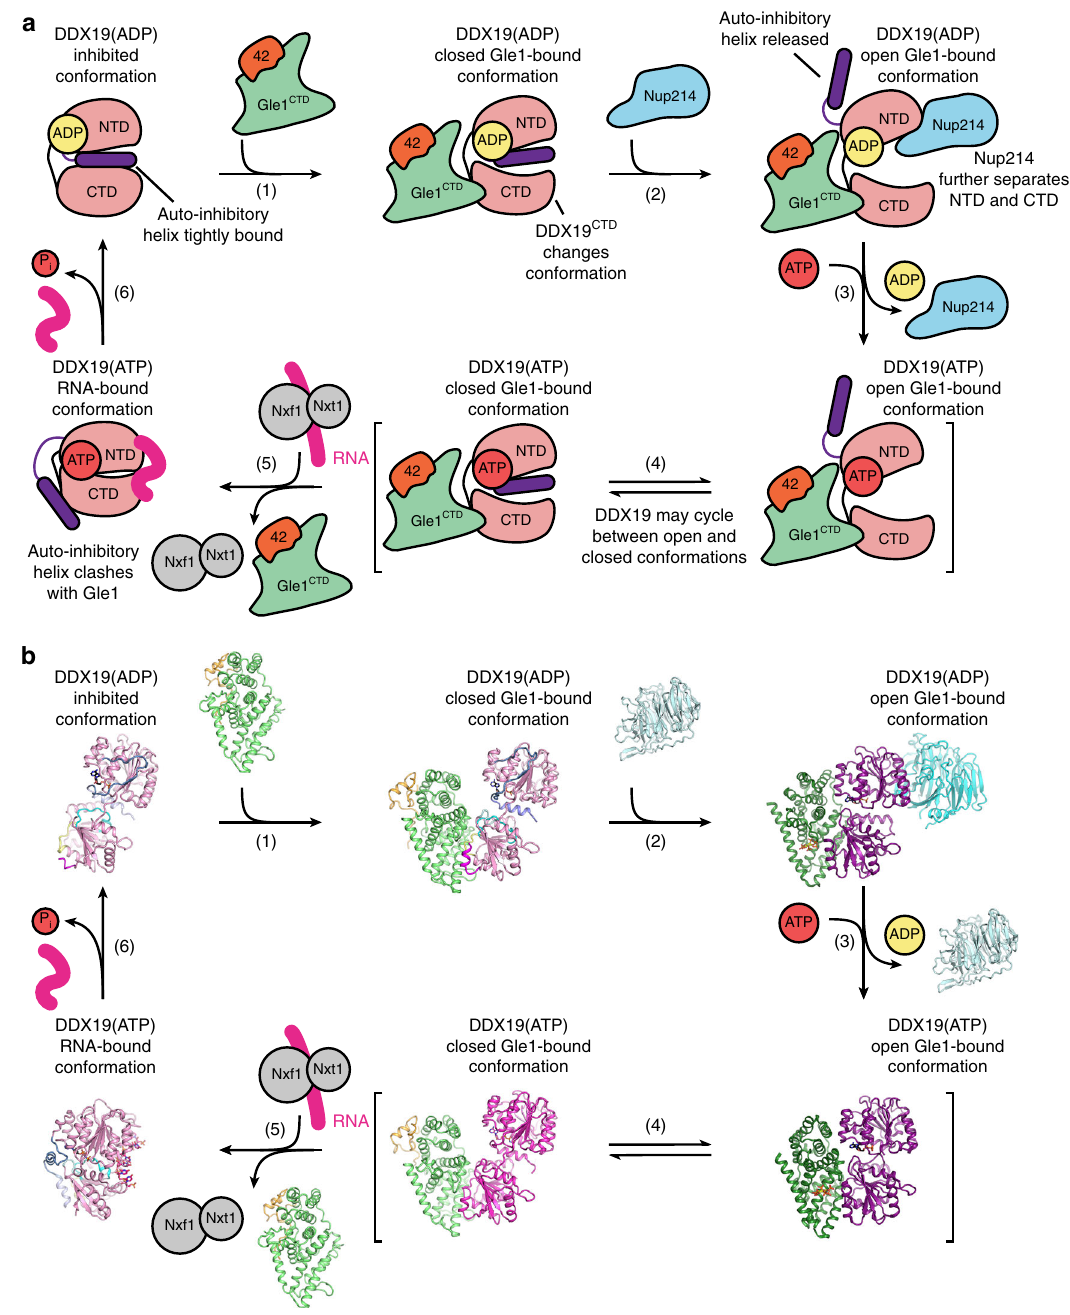
Fig. 8 Proposed working model for the DDX19 catalytic cycle. a Schematic cartoon of the DDX19 catalytic cycle. b Schematic of the DDX19 catalytic cycle with crystal structures of each state. The inhibited conformation corresponds to the crystal structure of DDX19 Δ N53 (ADP) (PDB ID 3EWS) 44 . The closed Gle1-bound conformations correspond to the crystal structures of Gle1 CTD (cid:129) Nup42 GBM (cid:129) DDX19 Δ N53 (AMP-PNP (cid:129) Mg 2 + ) and Gle1 CTD (cid:129) Nup42 GBM (cid:129) DDX19 Δ N53 (ADP). The Gle1-bound open conformations correspond to the yeast Gle1 CTD (cid:129) IP 6 (cid:129) Dbp5 Δ N90 (ADP) and Gle1 CTD (cid:129) IP 6 (cid:129) Dbp5 Δ N90 (ADP) (cid:129) Nup159 NTD (PDB IDs 3RRM and 3RRN) 10 . The RNA bound conformation corresponds to the crystal structure